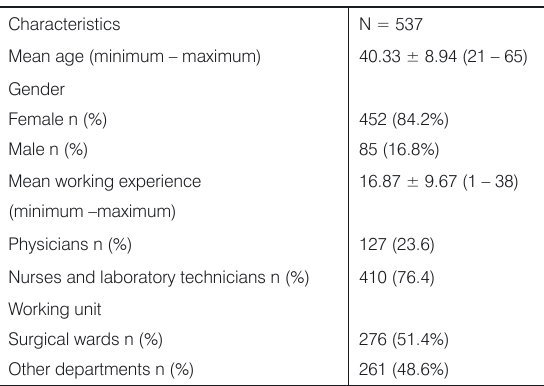
Table 1. Sociodemografic characteristics of